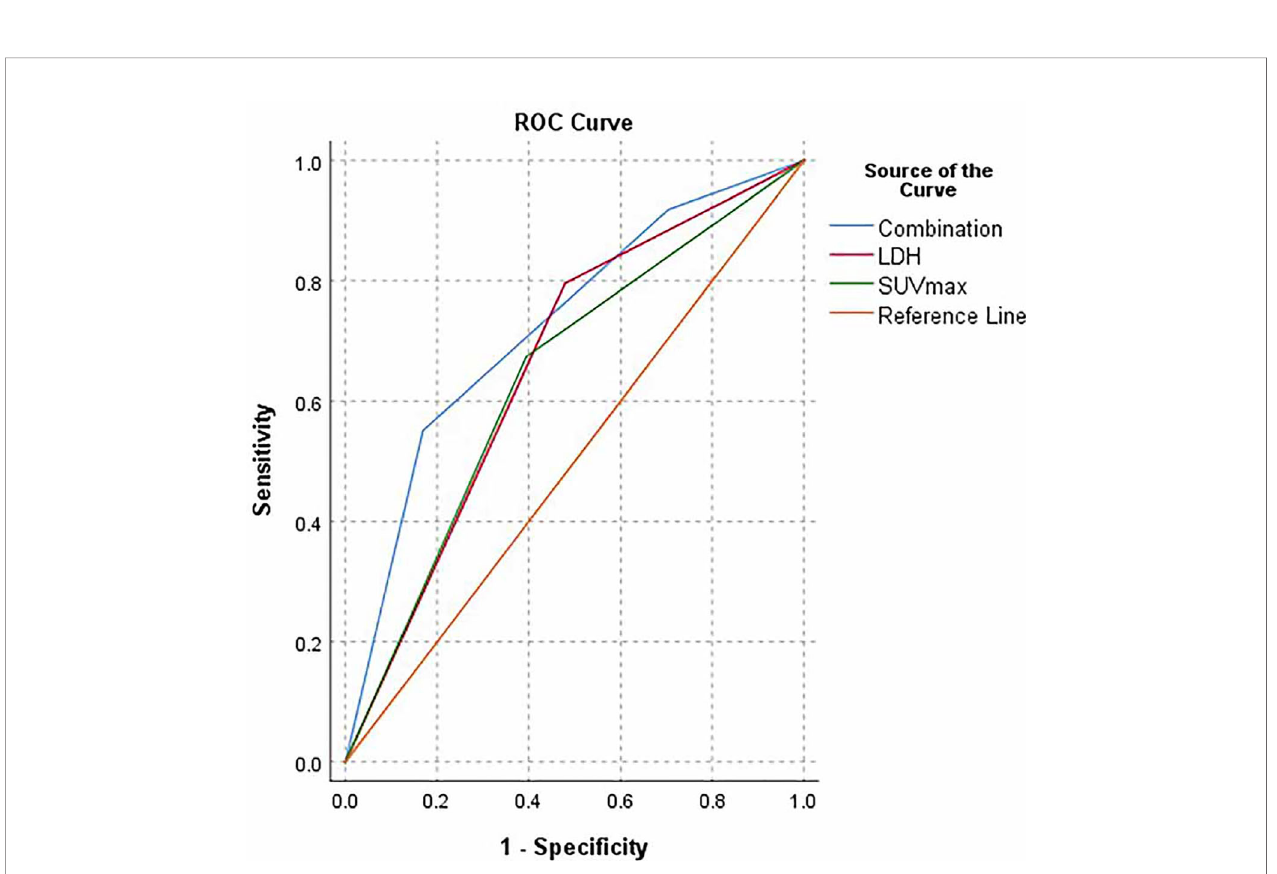
FIGURE 2 | ROC curve of LDH (<245 VS ≥ 245), SUVmax(<11.42 vs ≥ 11.42), Combination group (Low group, LDH<245 and SUVmax<11.42; intermediate group, LDH<245 or SUVmax<11.42; high group, SUVmax ≥ 11.42 and LDH ≥ 245),